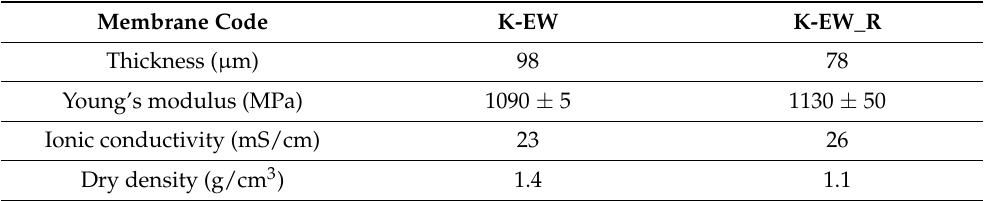
Figure 4. Swelling data of K-EW membranes. Table 2. Fully hydrated thickness, Young’s modulus, ionic conductivity and dry density of K-EW